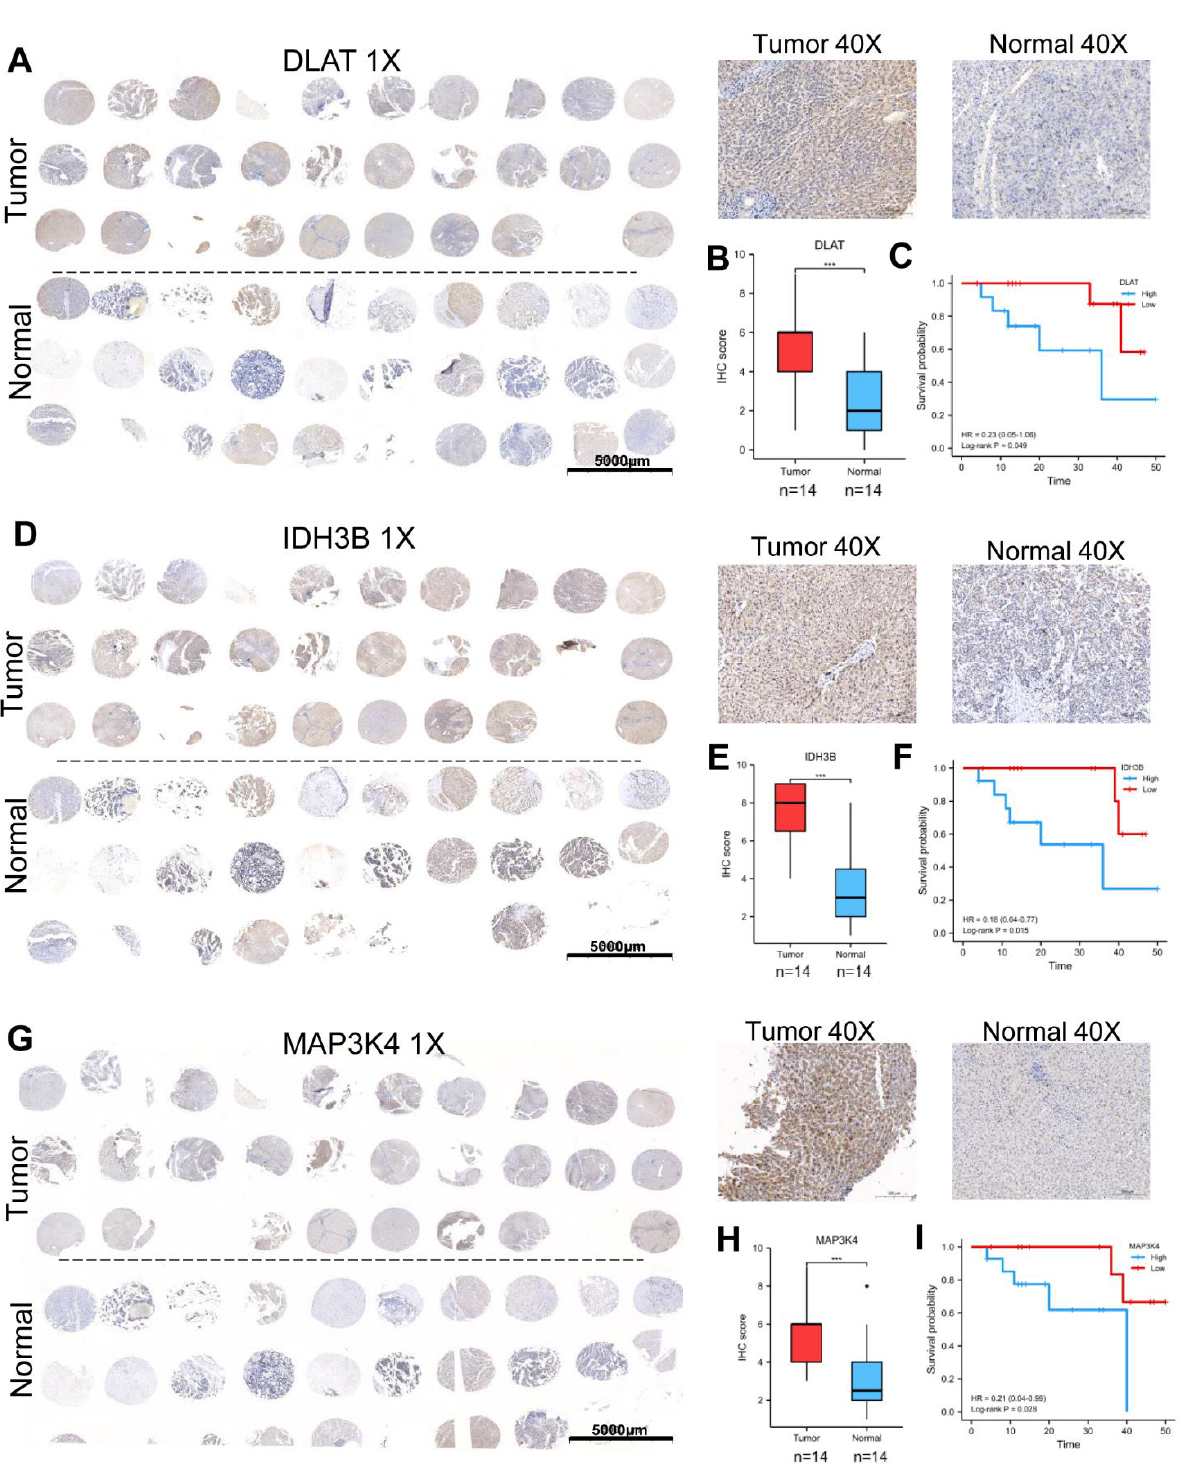
Figure 6. Validation of the expression and prognosis in a real-world HCC cohort. ( A – C ) The expression level and prognostic value of DLAT were analyzed by IHC and survival curve. ( D – F ) The expression level and prognostic value of IDH3B were analyzed by IHC and survival curve. ( G – I ) The expression level and prognostic value of MAP3K4 were analyzed by IHC and survival curve. *** p < 0.001.